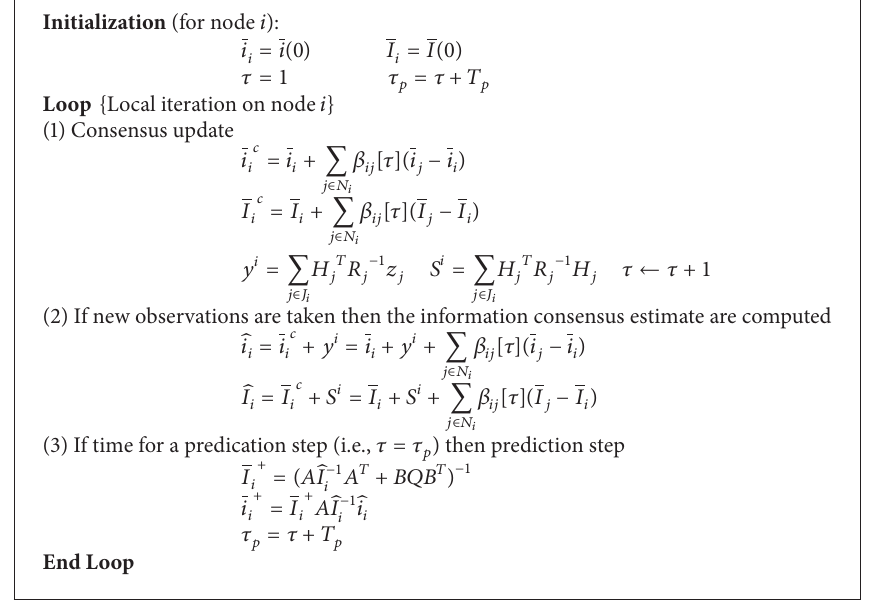
Algorithm 3: Information consensus